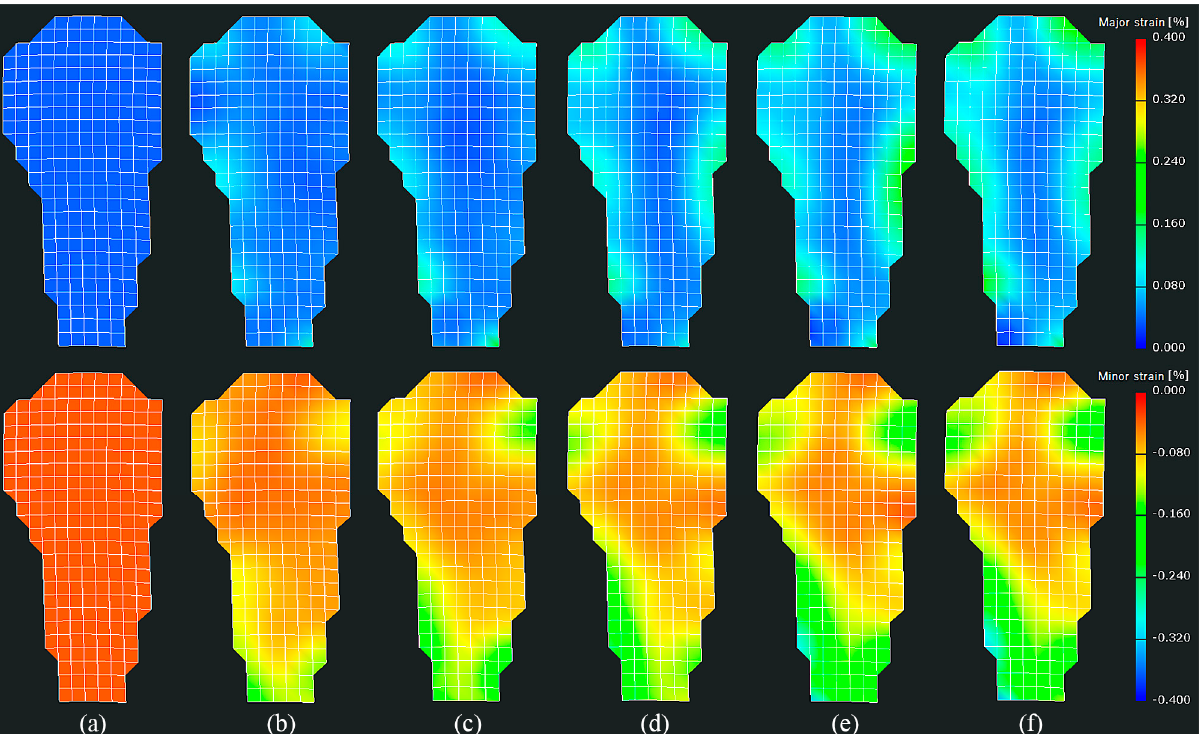
Figure 4. Full-field buccal surface strains of the specimen (shown in Figure 3) at ( a ) stage 0, ( b ) stage 5, ( c ) stage 10, ( d ) stage 20, ( e ) stage 30, and ( f ) stage 39. The first row displays the major strain (or tensile strain) map, while the second row displays the minor strain (or compressive strain) map.